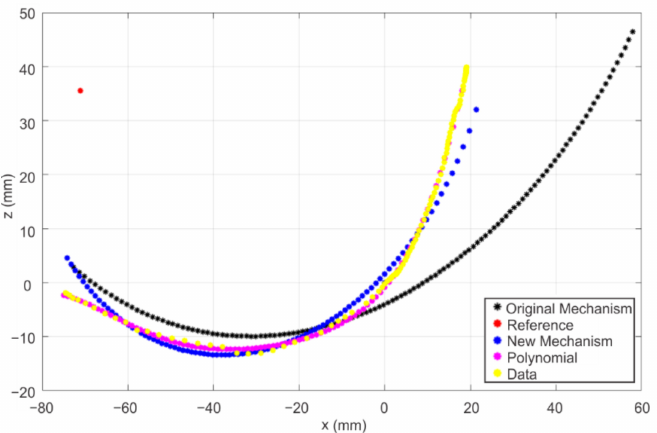
Figure 19. Results of the genetic algorithm